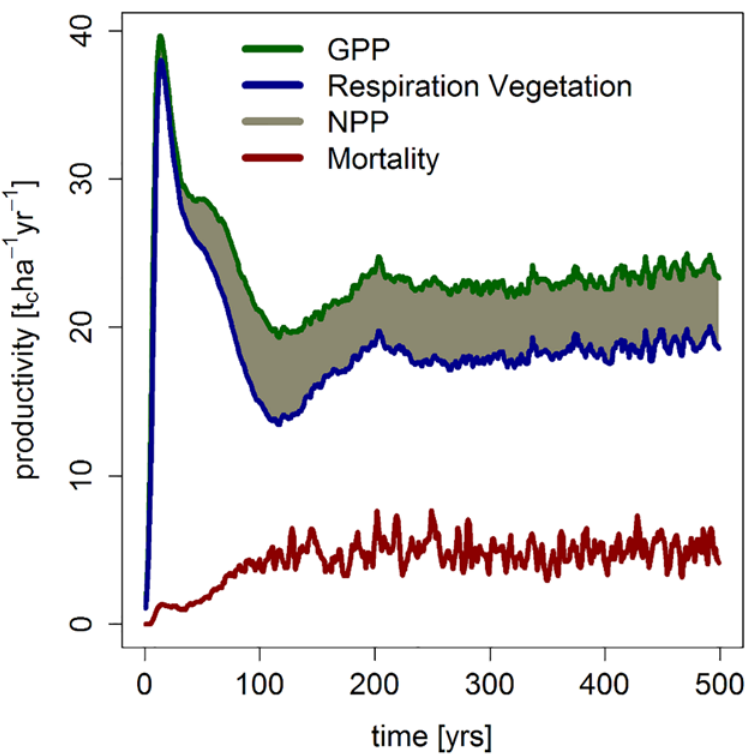
the loss of biomass due to mortality events.